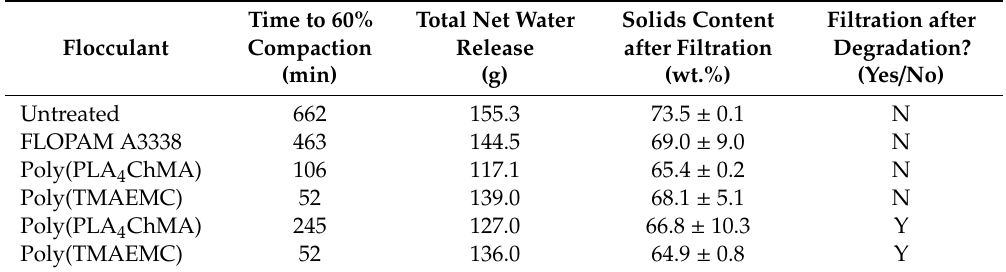
Table 1. Summary of net water releases and cake compactions from filtration experiments. TMAEMC: trimethylaminoethyl methacrylate